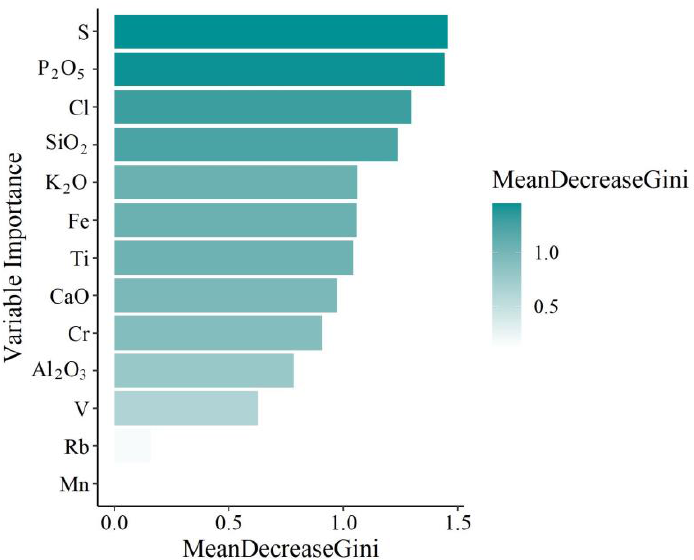
Figure 4. Variables importance determined by the Random Forest algorithm for quartz variety dis- crimination.